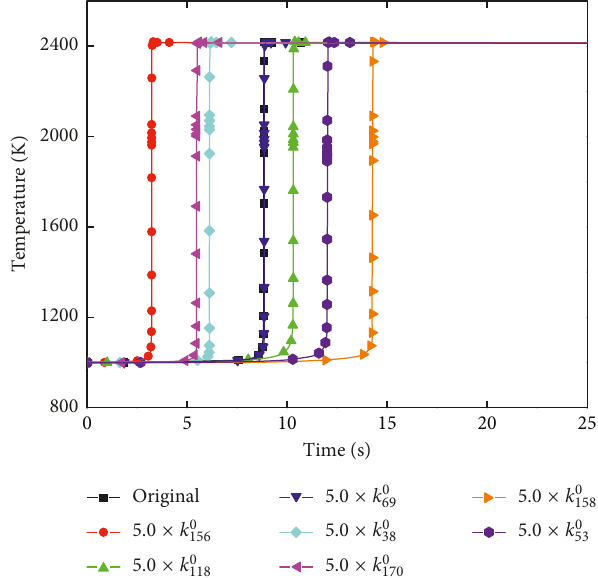
Figure 6: The temperature profiles predicted by an original combustion model and 7 modified models at a stoichiometric CH4/air mixture under pressure of 0.1atm and temperature of 1000K. 5 . 0 × k 0 i indicates that the rate of the reaction (i) of this modified model is calculated with original reaction rate k 0 i mul- tiplied by 5.0, and other reaction rates of the modified model are the same as those of the original